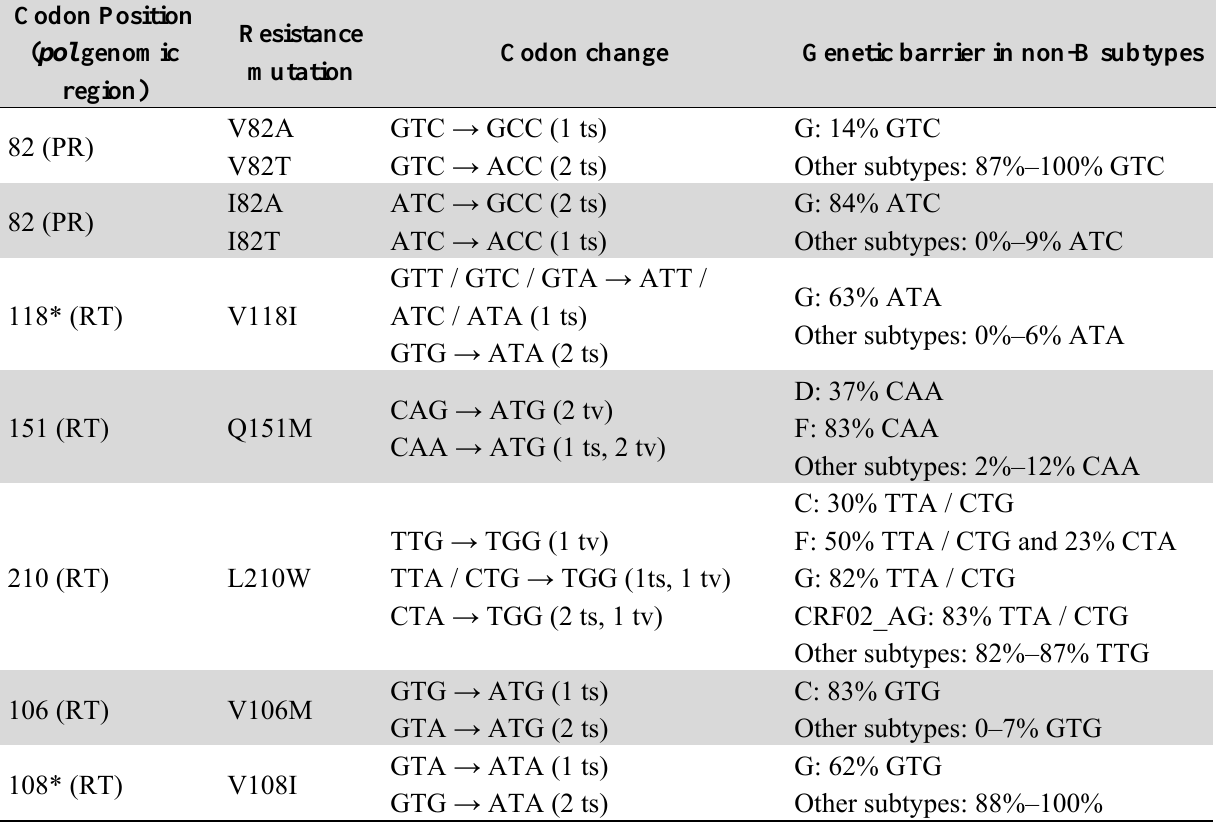
Table 4. Drug resistance mutation and genetic barriers for HIV-1 group M